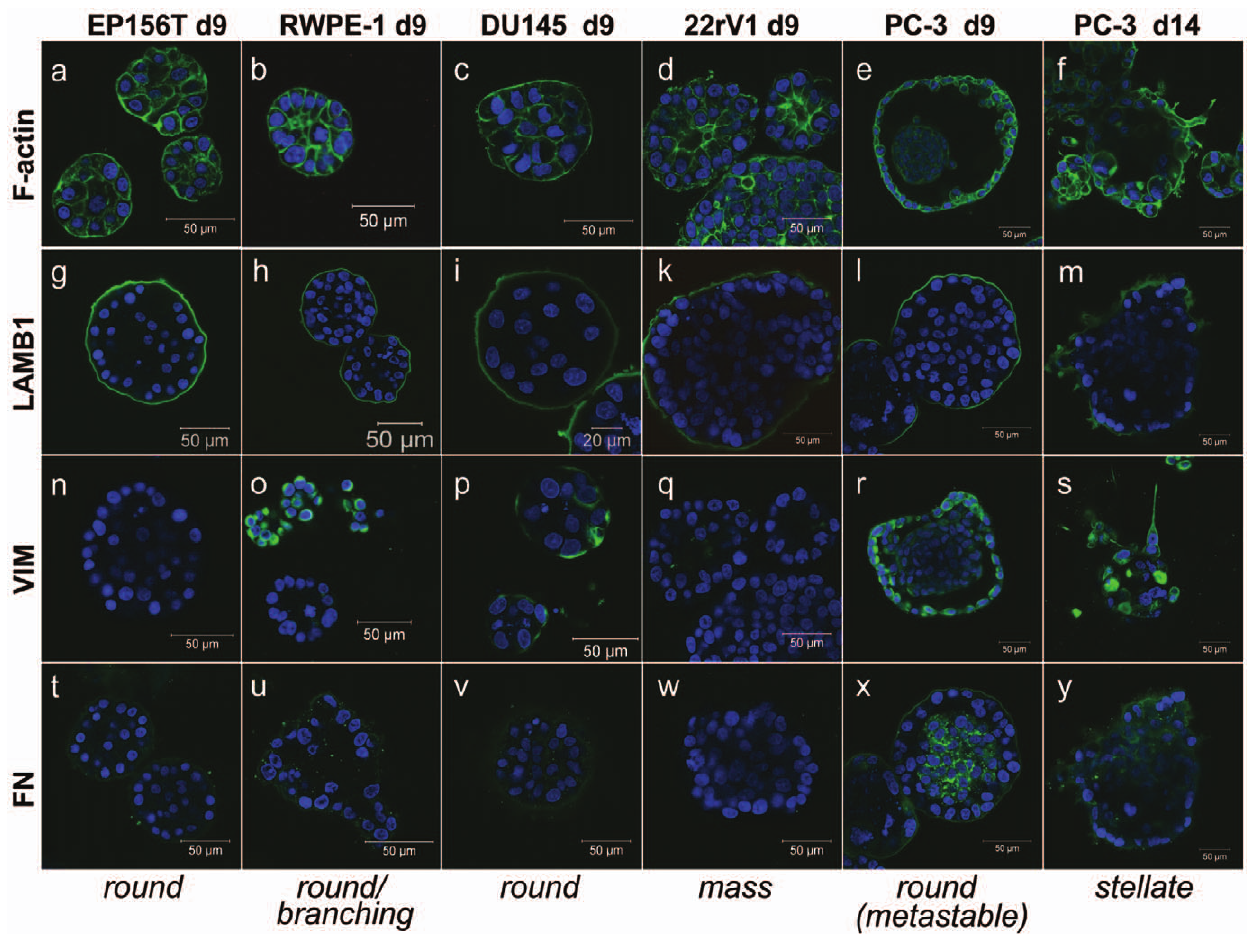
Figure 3. Representative immune cytochemistry staining of spheroids structures, grown for 9 or 14 days in Matrigel, using antibodies against the basal-lamina component laminin beta 1 (LAMB1), and the mesenchymal markers vimentin (VIM), and fibronectin (FN). Alexa488-labeled phalloidin was used to detect F-actin and Hoechst stain to label nuclei (blue). RWPE1, DU145 and PC3 cells show expression of EMT-related mesenchymal markers, regardless of phenotype (PC-3 cells; round at day 9, stellate at day 14).